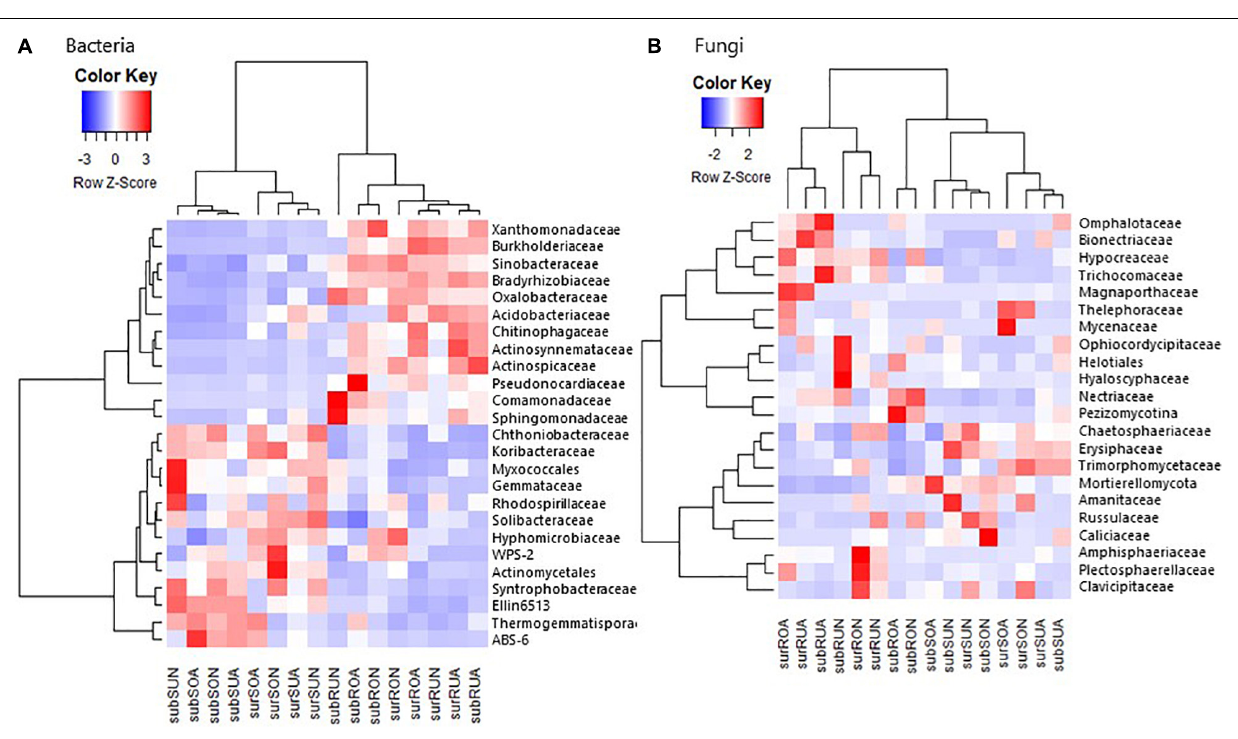
Relative abundances of ECM taxa classified by FUNGuild were significantly greater in native than in acacia for subsurface soil in both Oxisols and Ultisols ( Figure 5A ). The dominant ECM taxa in native forests were the Tomentella spp., Russula